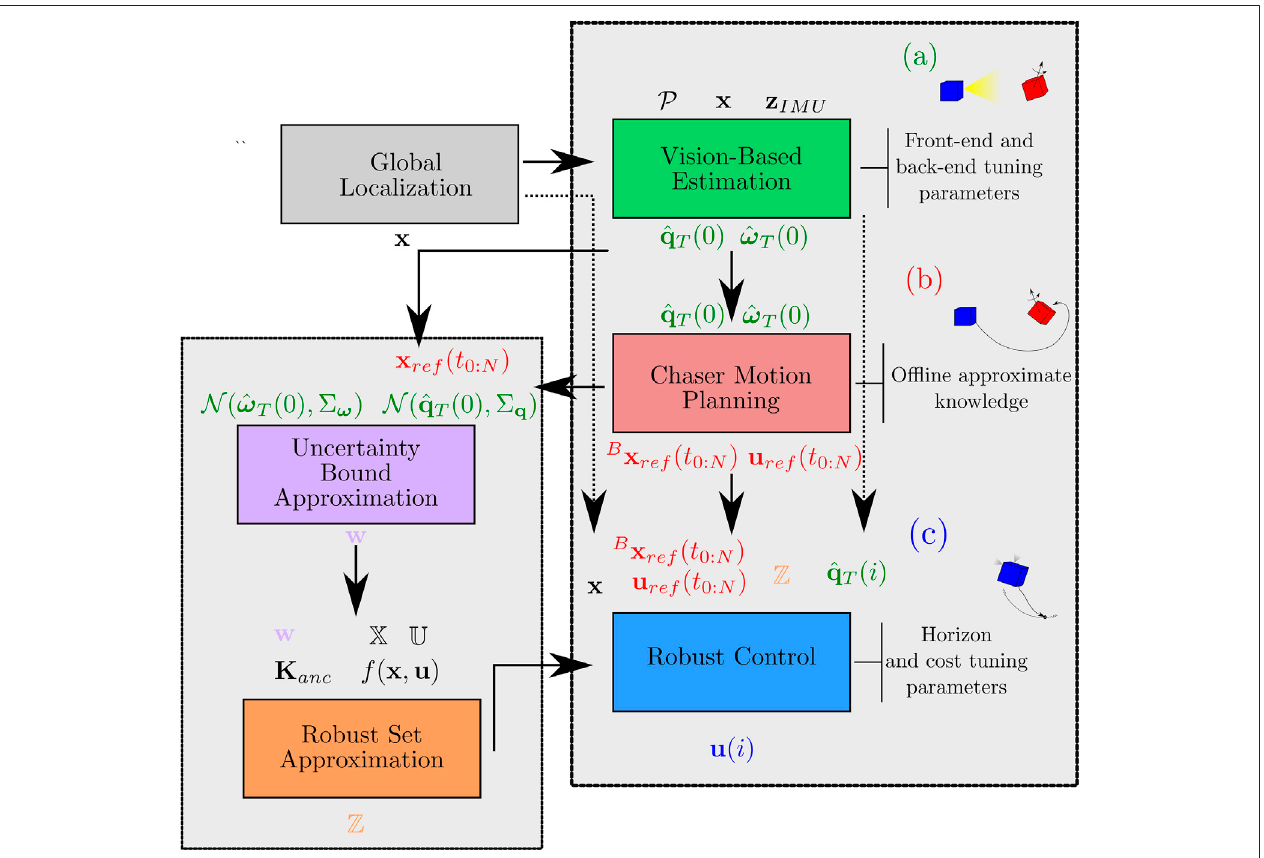
FIGURE 4| The full algorithmic pipeline, showing major inputs and outputsof each component algorithm. Inputs are shown above, and outputsare shown below. (A) shows the SLAM and polhode analysis visual estimation of the Target, (B) shows the online motion planning component, and (C) shows the robust model predictive controller and its supporting